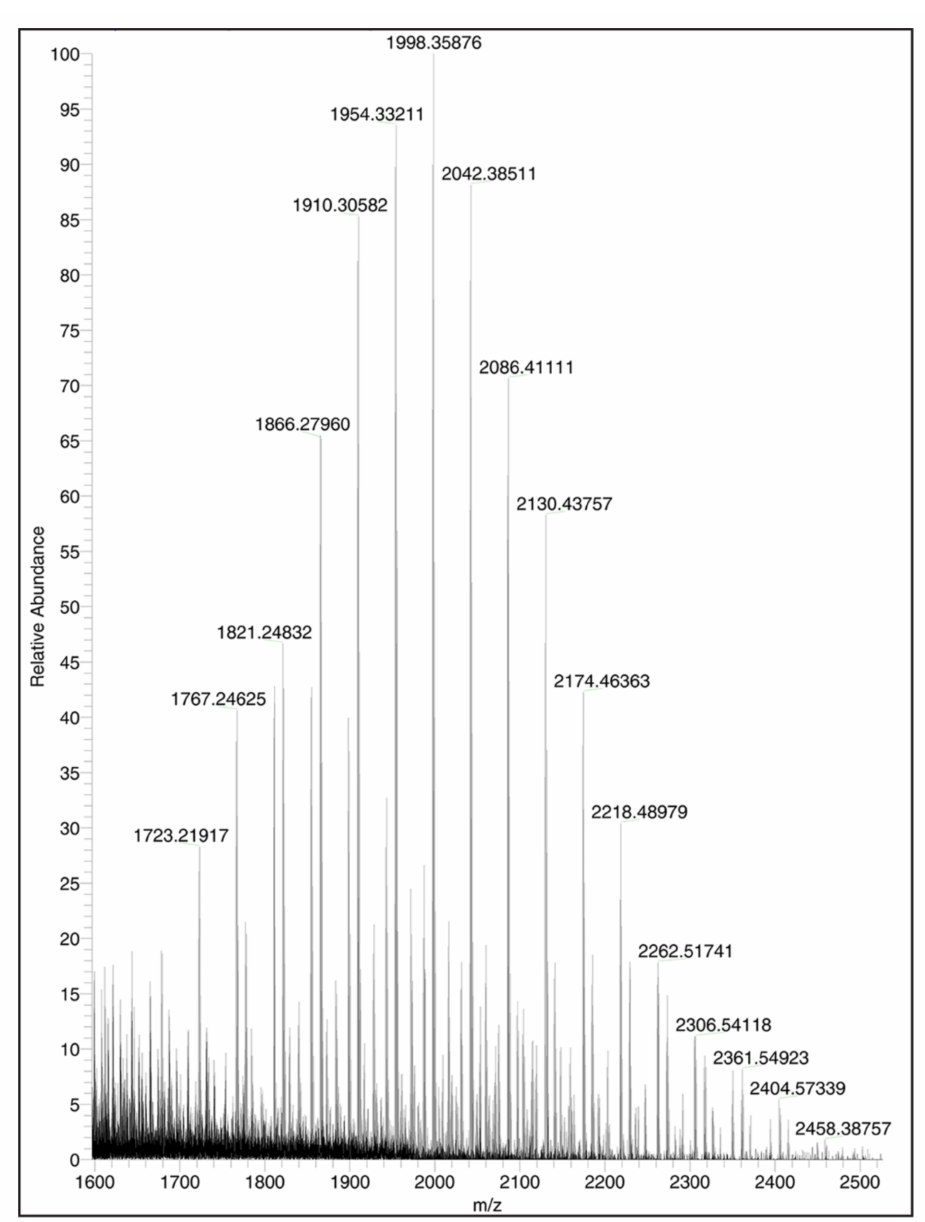
Figure 5. Mass spectrum of BBA-1. Synthesis of BBA-1 after CSA-90 and ALN conjugation is evident by the presence of distinctive ions corresponding to total mass of CSA-90, NHS-PEG-COOH linker and alendronate conjugation (BBA-1) spaced by m/z of ~44 arising from the polydispersity of the PEG